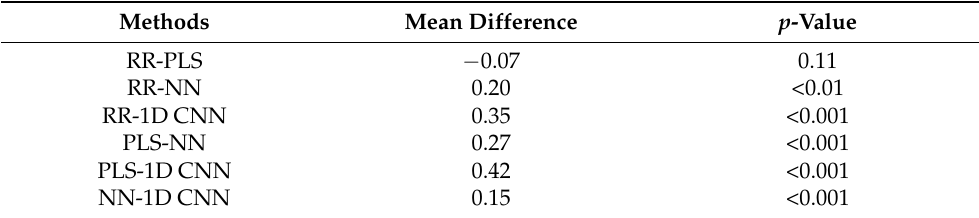
Table 5. Paired t -test to evaluate differences between the absolute errors of predictions for each pair of methods applied ( α = 0.05) in the 175 samples of the independent test set. Methods Mean Difference p -Value RR-PLS − 0.07 0.11 RR-NN 0.20 <0.01 RR-1D CNN 0.35 <0.001 PLS-NN 0.27 <0.001 PLS-1D CNN 0.42 <0.001 <0.001